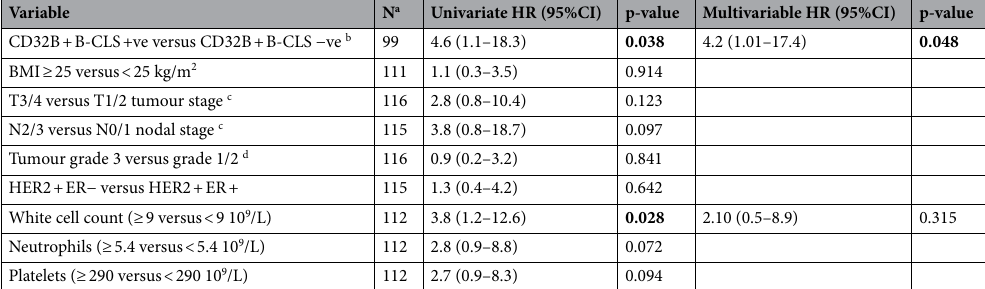
Table 1. Univariate and multivariable analysis for time to metastatic disease of the trastuzumab-treated patients comparing the presence of CD32B + B-CLS +ve versus CD32B + B-CLS −ve patients. B-CLS, CLS at the adipose-tumour border; a number of cases for which data was available; b CD32B + B-CLS -ve, patients with CD32B- B-CLS, no B-CLS or any CLS; c as per TNM Classification of Malignant Tumours (8th edition); d as defined by Nottingham grading system; Bold, statistically